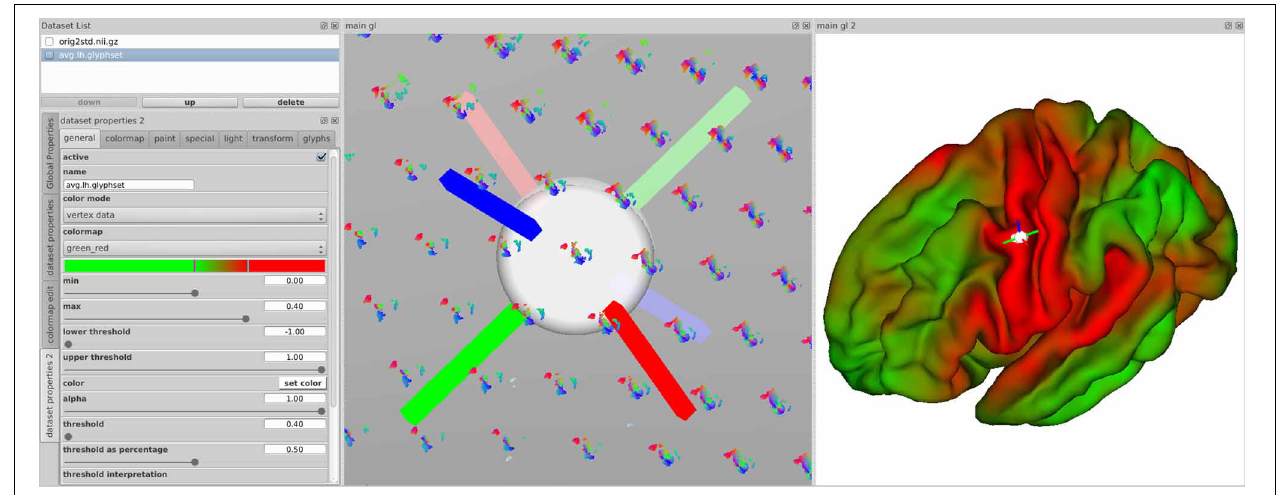
FIGURE 10 | Synchronized views of the data in brainGL showing visualization properties (Left), glyphs (Middle) and the color-mapped connectivity of a selected point (Right). Clicking on a node leads to the display of coordinate markers in both